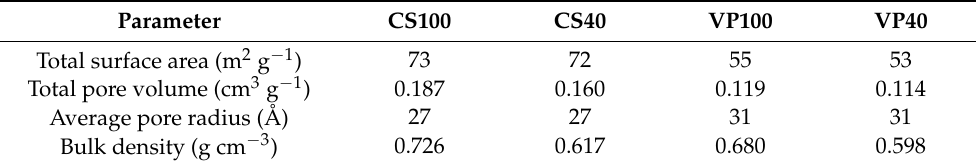
Table 2. Physical properties of the micronized and thermally treated zeolites. Parameter